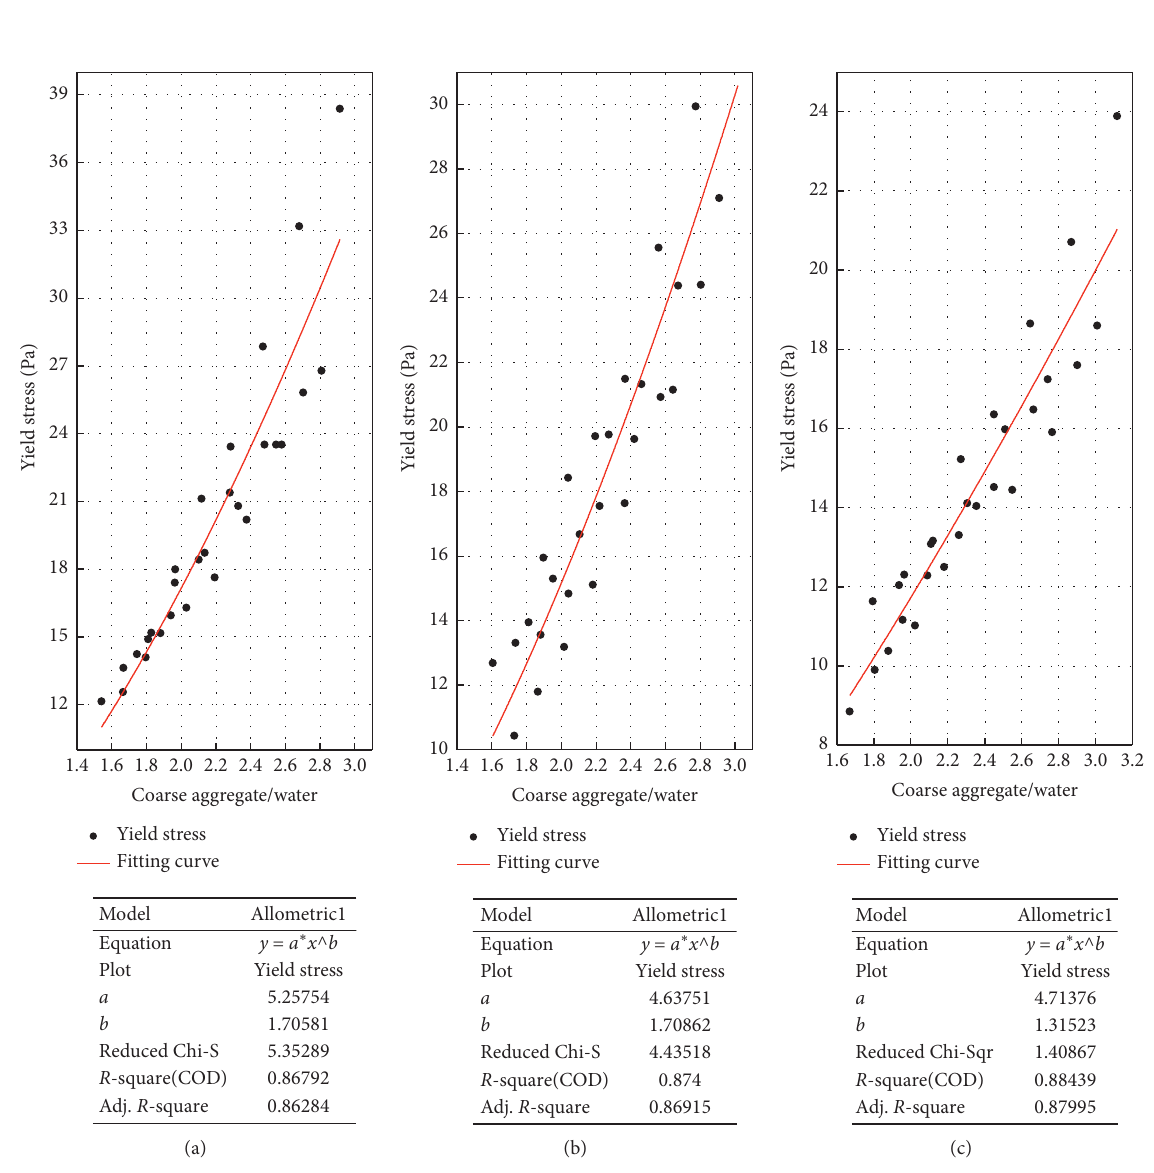
Figure 11: Relationship between the ratio of the mass of the coarse aggregate to the mass of the water and yield stress. (a) Waste rock: desert sand � 5 :5. (b) Waste rock: desert sand � 6: 4. (c) Waste rock :desert sand � 7: 3.